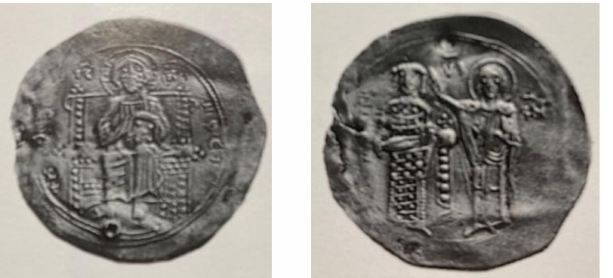
Figure 6. Third Indiction Hyperpyron Nomisma, 1137–1143; impression on gold; Dumbarton Oaks, Washington D.C.; 3b.3 Shaw 1947. Published at [15] (Ibid, pp. 261–274. The issues from the mint at Thessalonike have St Demetrios, the patron saint of the city, while those from Constantinople have St George. Images on Plates VIII and IX).